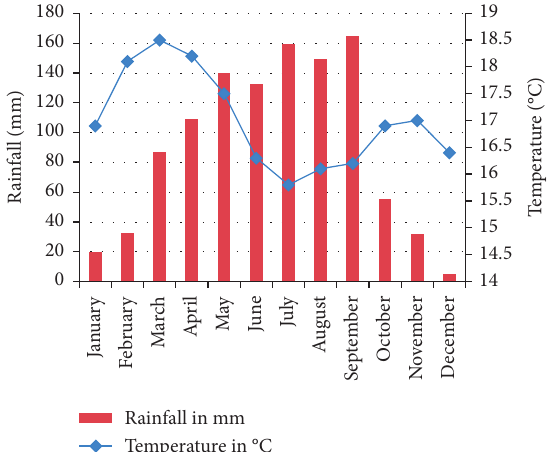
Figure 2: Mean monthly rainfall and temperature of the study